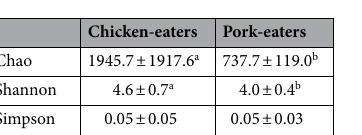
Table 2. Alpha diversity of human fecal microbiota. a,b Means differed significantly ( P < 0.05).